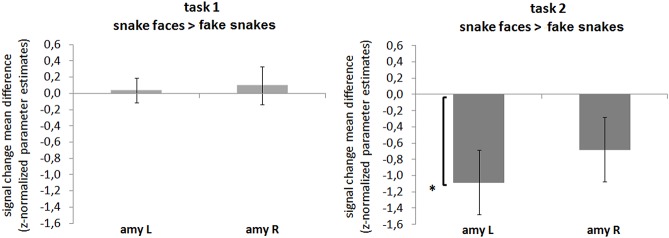
ROI amygdala: Effect of stimulus type.Responses of the amygdala to the snake faces are smaller than to the fake snake stimuli, showing differential decreased activation in a task and amygdala dependent manner. The left amygdala is preferentially involved in the discrimination of threatening and non-threatening stimuli during the threat detection task (task 2). ROI RFX-GLM contrasts: mean differences in parameter estimates (z-normalized beta-values) for the contrasts ‘snake faces > control fake snakes’, task 1 (A) and 2 (B) are displayed. Legend: amy L, amygdala left; amy R, amygdala right; *p<.05. The bars display the standard error of the mean (SE).